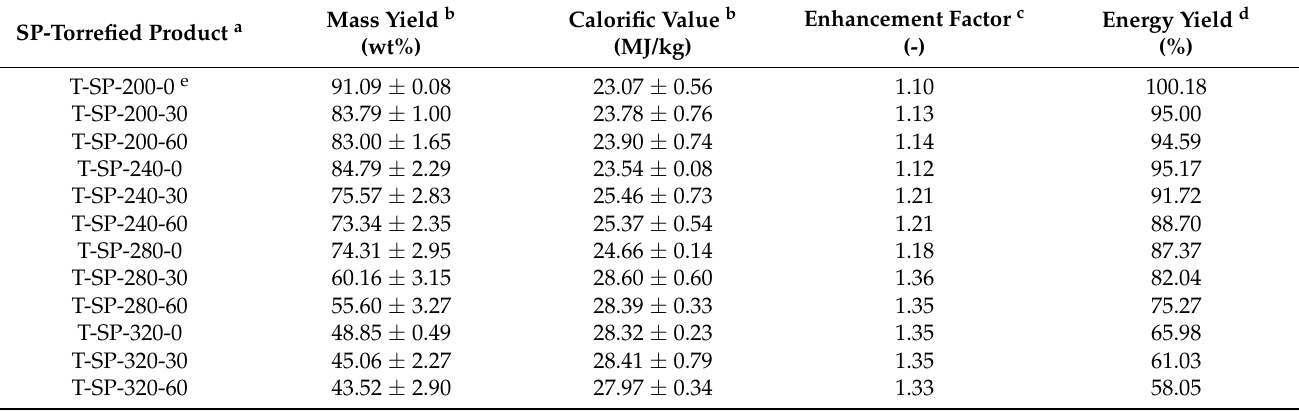
Table 2. Mass yields and calorific values of SP-torrefied products (T-SP) as a function of the temperature (200–360 ◦ C) and residence time (0–60